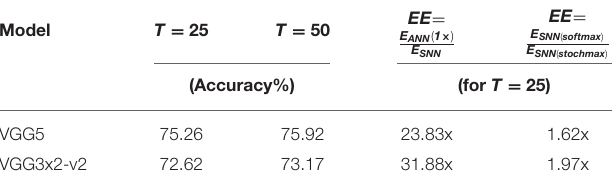
TABLE 11 | Accuracy and EE benefits for AGD trained SNN with stochmax classifier on VGG5/VGG3x2-v2 topology (refer to Table 9 ) for different latency T = 25,50 on CIFAR10 data.